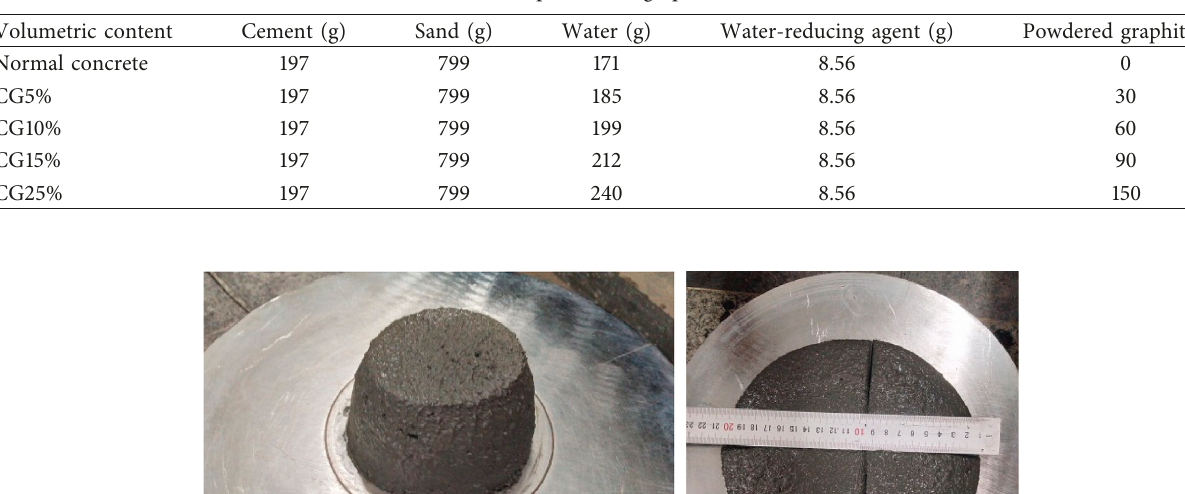
Table 1: Composition of graphite concretes.